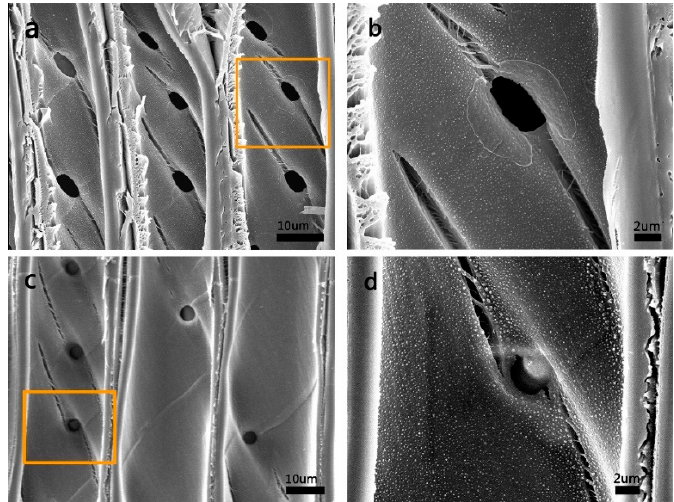
Figure 4. SEM micrographs of cross-field pit and bordered pit region in the high-intensity MW-treated sample: ( a ) Cracks near cross-field pits and detachments in middle lamella, ( b ) amplified crack near a cross-field pit, ( c ) cracks near bordered pits and detachments in middle lamella, ( d ) amplified crack near a bordered pit.